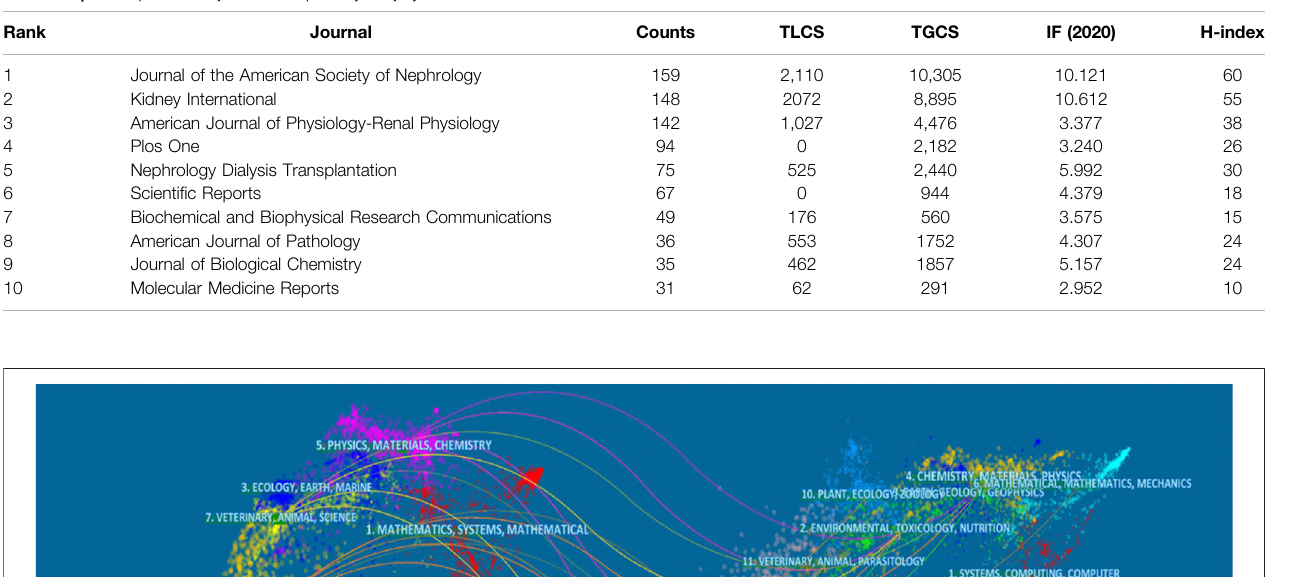
TABLE 4 | The top 10 core journals on podocyte injury research.